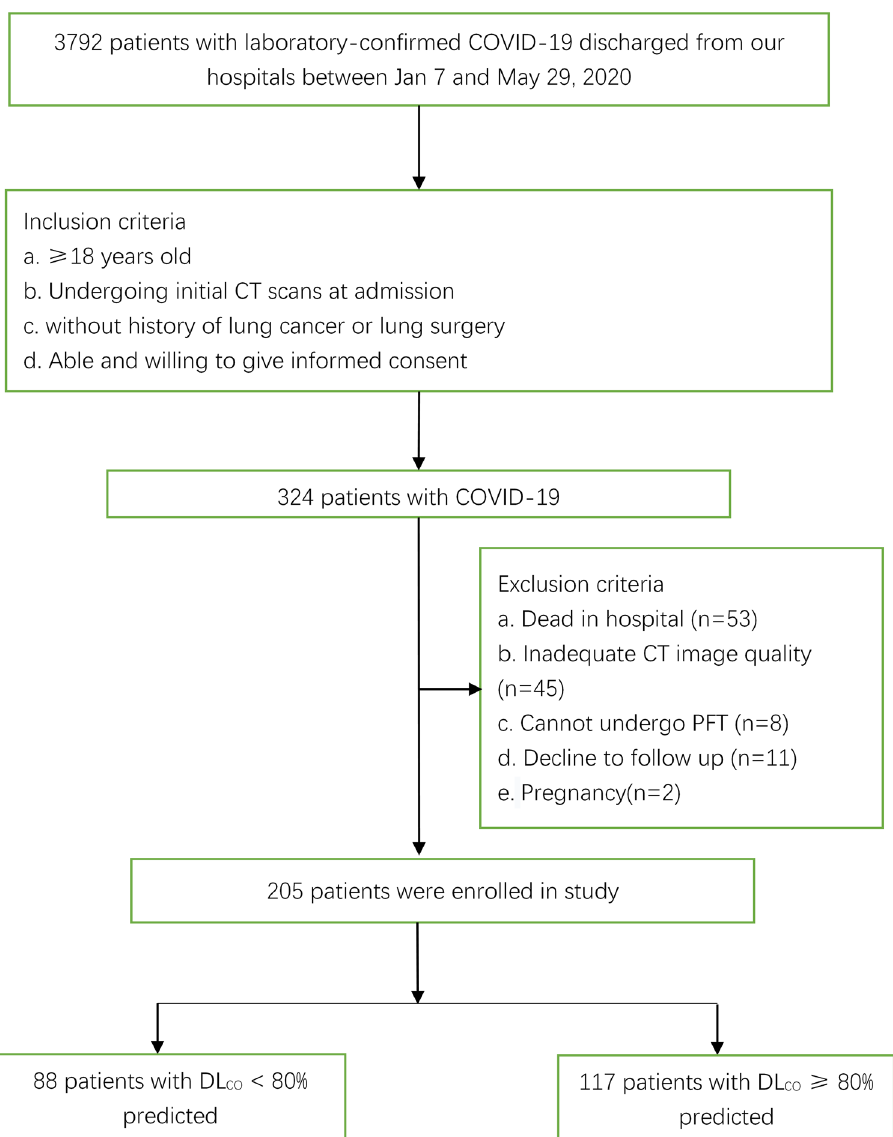
Figure 1. Flow diagram of participant inclusion. PFT pulmonary function test, DL CO carbon monoxide diffusion